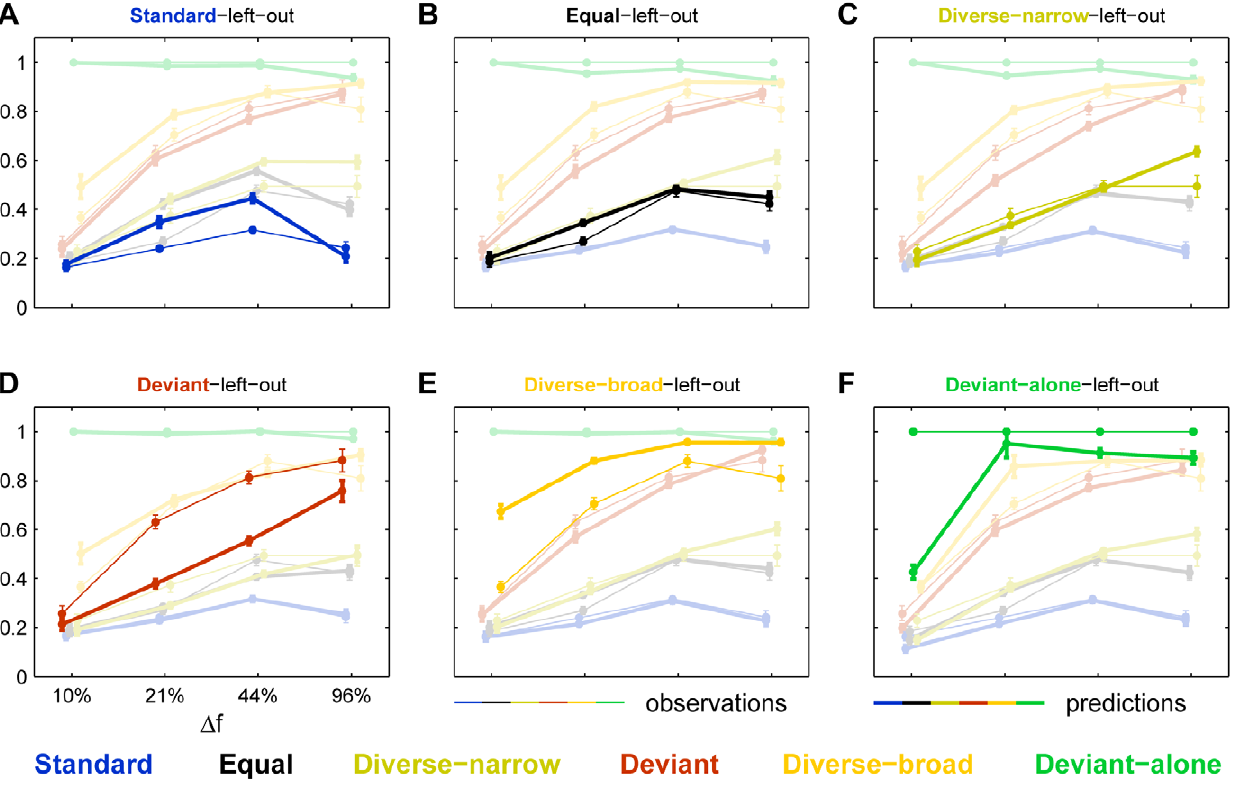
Figure 13. Comparing the leave-one-out model predictions with experimental observations. A-F. Comparison of the average LFP responses at the six stimulation conditions and four values of D f (thin lines, the same in all panels) with the predicted responses from models in which one condition (denoted at the title of each panel) was left out of the training data (thick lines). Error bars: s.e.m. The data of the left-out condition is displayed in saturated color, while the data for the conditions that were part of the training set are displayed in faded